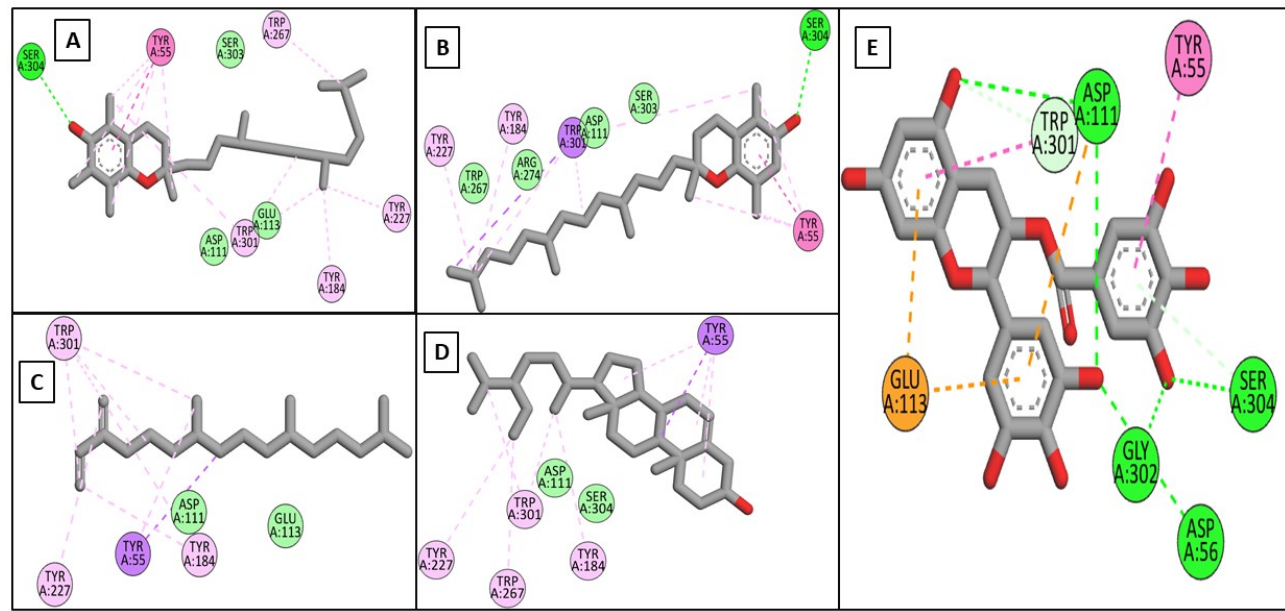
Figure 6. 2D binding modes of α -tocopherol ( A ), β -tocopherol ( B ), neophytadiene ( C ), γ -sitosterol ( D ), and EGCG ( E ) to the active binding sites of hyaluronidase.